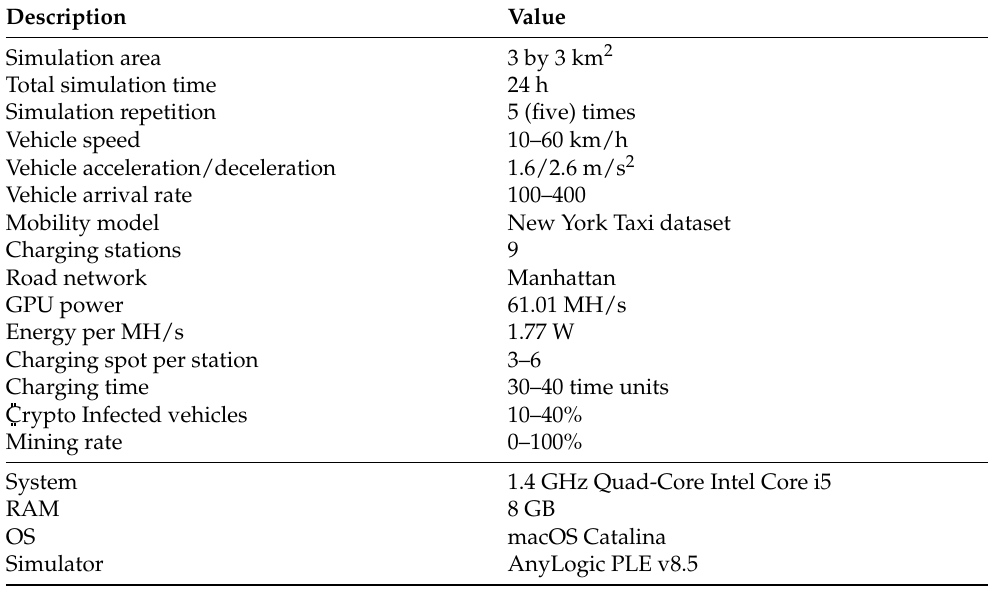
Table 2. Simulation config and system